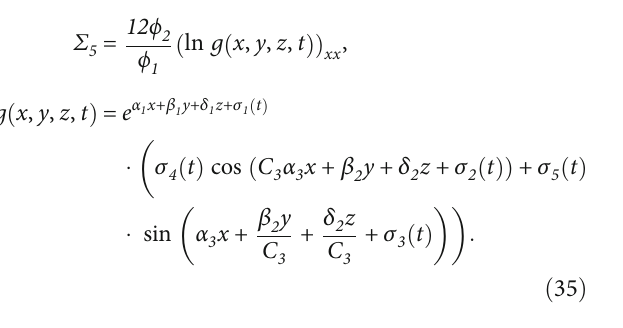
Þ (3D plot, density plot, and 2D plot t ), 5